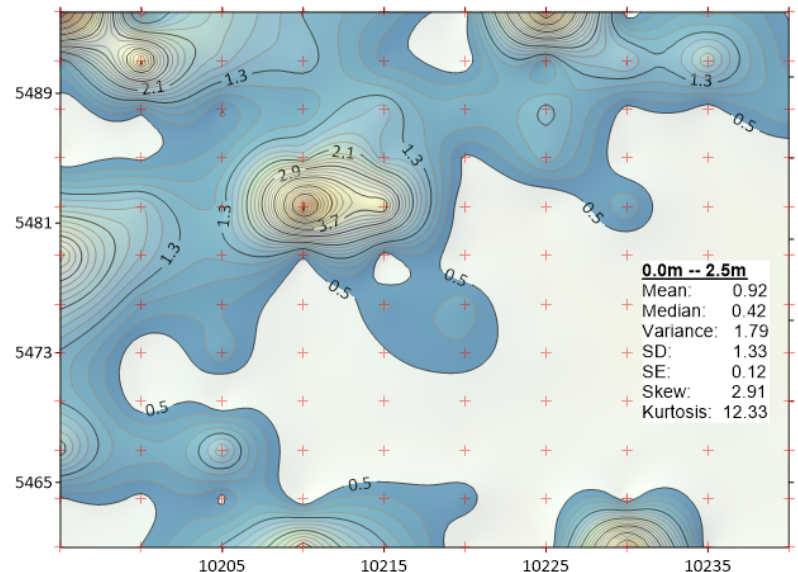
Figure A1. Distribution of ore in the form of isopath from RL455 to RL452.5 obtained from kriging.